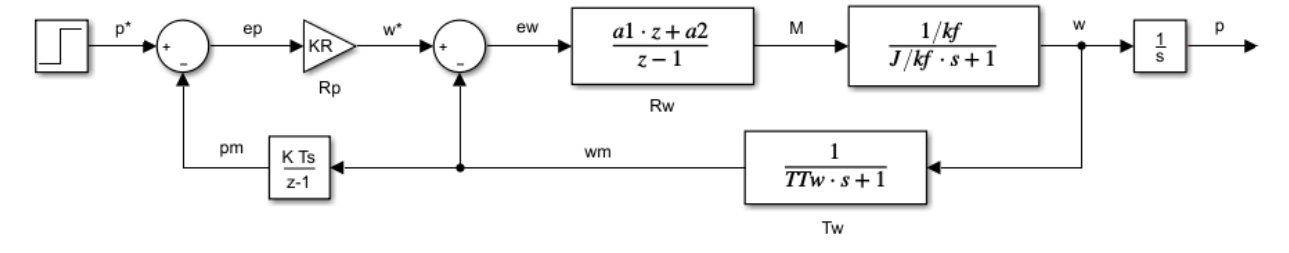
Figure 3. Block diagram of digital control system.